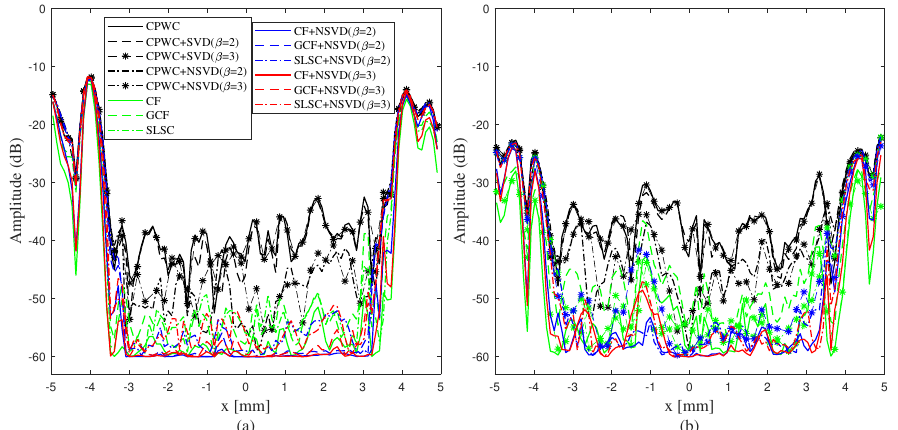
Figure 6. Lateral profiles of the simulated cyst targets centered at ( a ) ( x , z ) = ( 0 mm,18 mm ) , ( b ) ( x , z ) = ( 0 mm,42 mm ) .